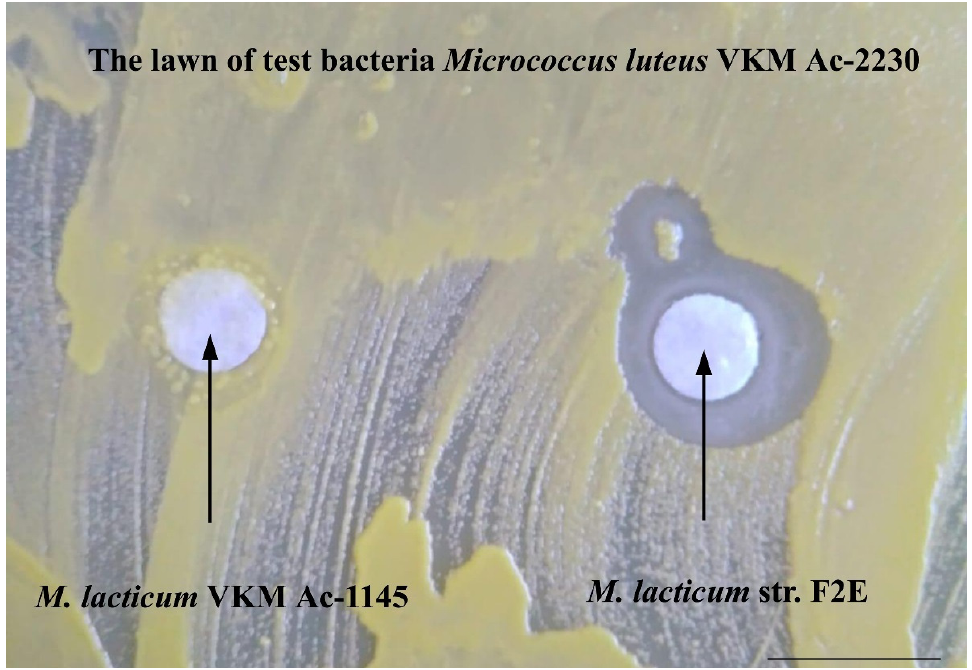
Figure 6. Inhibition of the growth of M. luteus VKM Ac-2230 by the strain F2E (24 h incubation, 28 °C). Bar—1 cm.